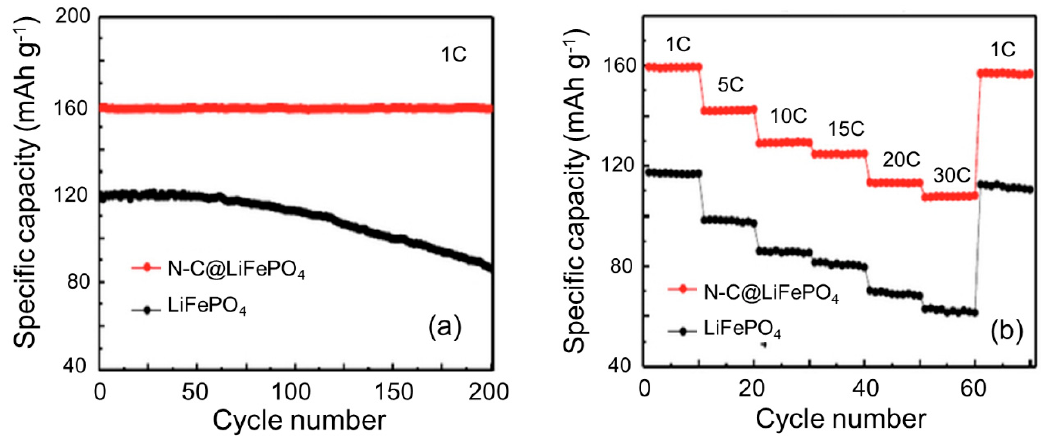
Figure 2. Electrochemical performance of LiFePO 4 (LFP) coated with N-doped carbon (N-C@LFP) and noncoated LFP nanospheres tested at 25 °C. ( a ) Cycling performance at 1 C. ( b ) Rate performance from 1 C to 30 C. Reproduced from [24].